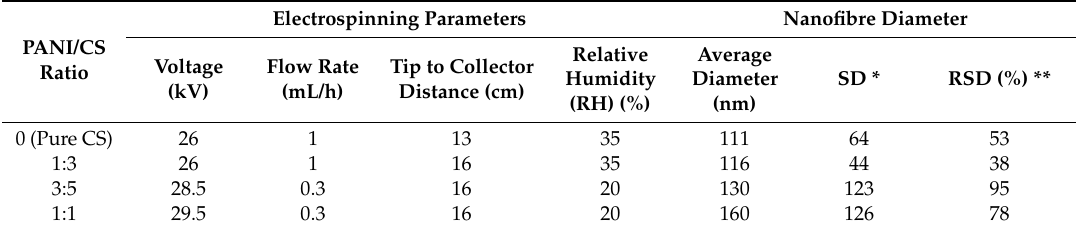
Table 1. Electrospinning parameters and resulting polyaniline–chitosan (PANI/CS) nanofibre diameters at different PANI